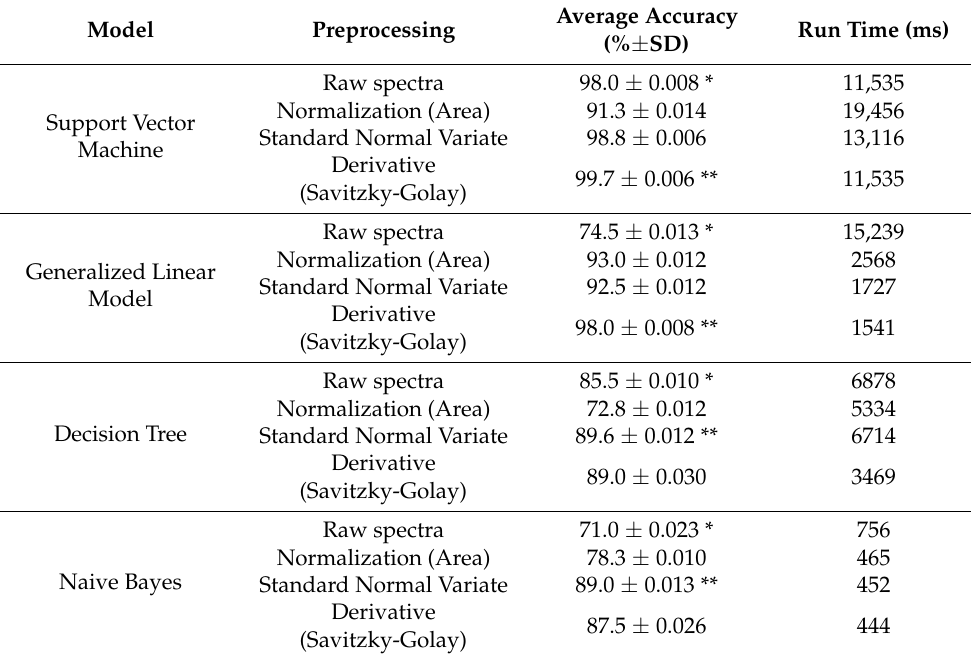
Table 2. Classification accuracy of the combinations of preprocessing and model for reflectance spectra from six Amaranthus sp.